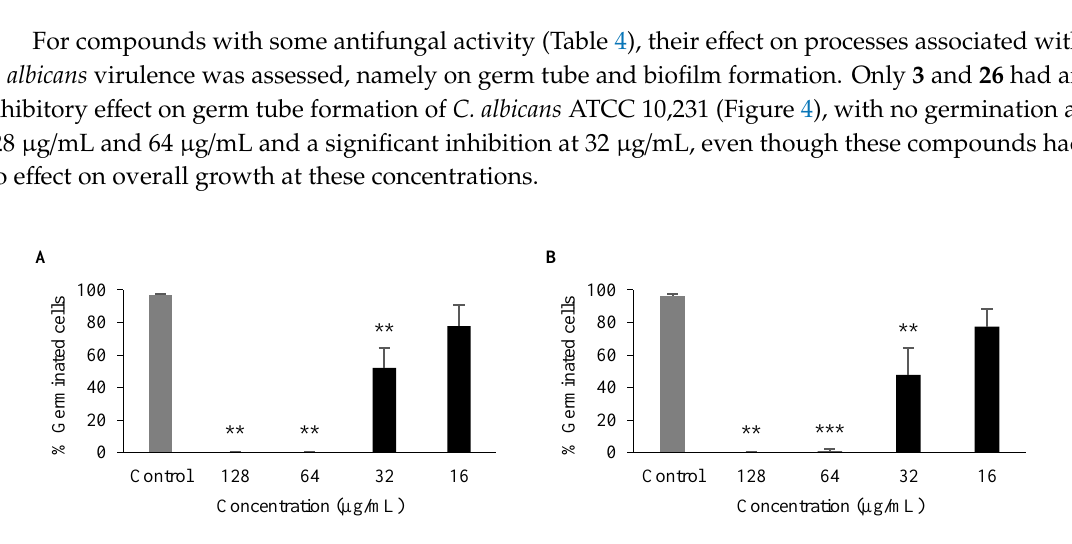
Figure 5. Percentage of C. albicans ATCC 10,231 biofilm formation after 48-h incubation with 3 ( A ), 26 ( B ). Data are shown as mean ± SD of three independent assays. One-sample t-test: * p < 0.05, ** p < 0.01, *** p < 0.001 significantly different from 100%.